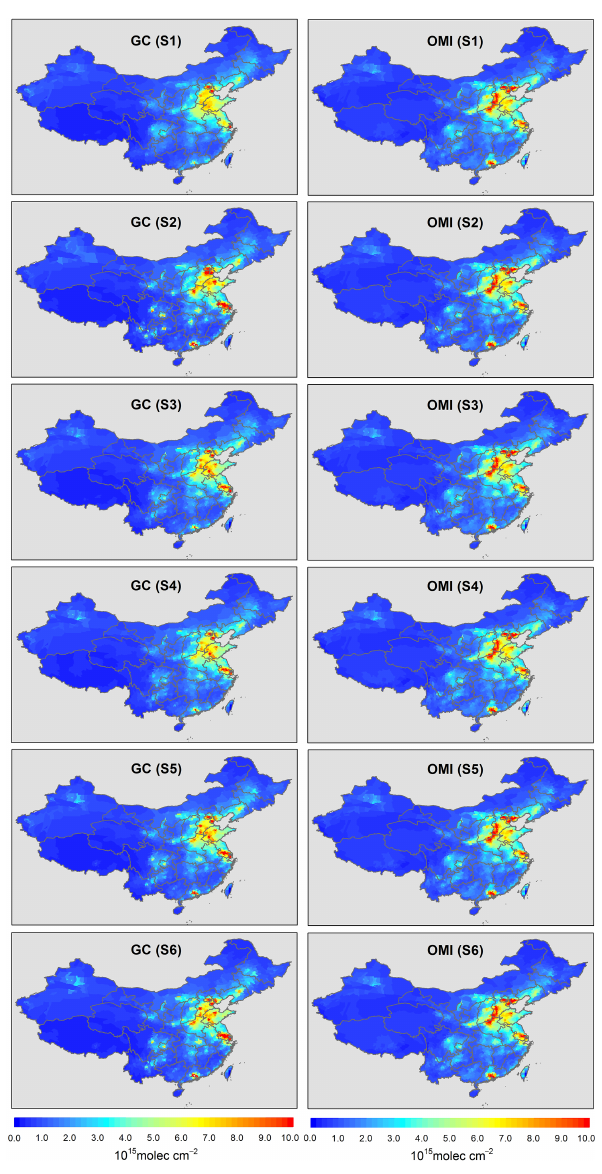
Figure 4. Spatial distributions of summer averaged tropospheric NO 2 vertical columns modeled by GEOS-Chem based on S1–S6 emissions and scenario-specific data retrieved from the OMI for